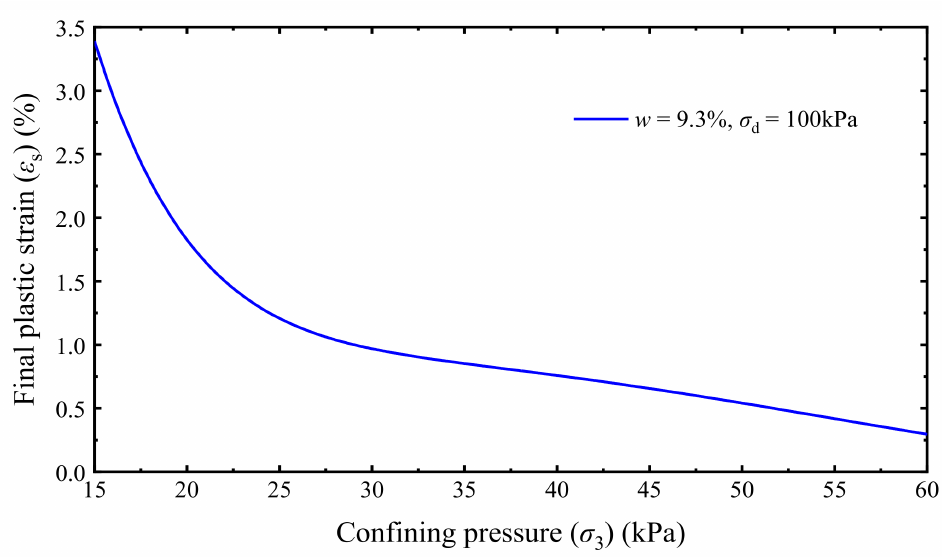
Figure 15. ε s - σ 3 relationship of saturation